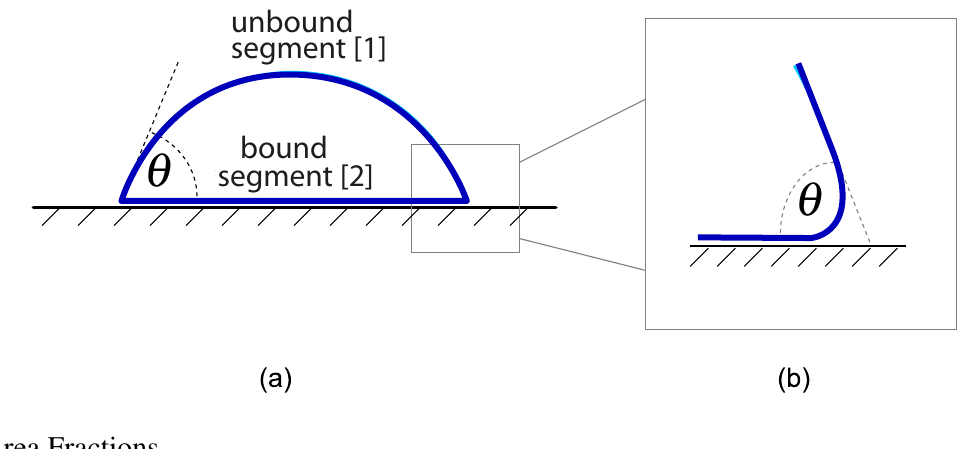
Figure 2. ( a ) Side view of a vesicle that strongly adheres to a planar substrate surface. The vesicle membrane (blue) consists of two segments: the unbound segment S [1] that forms a spherical cap with surface area A [1] and the bound segment S [2] with surface area A [2] . The two segments meet along the contact line with effective contact angle θ = θ viewed with increased resolution, the unbound membrane segment close to the contact line is smoothly curved